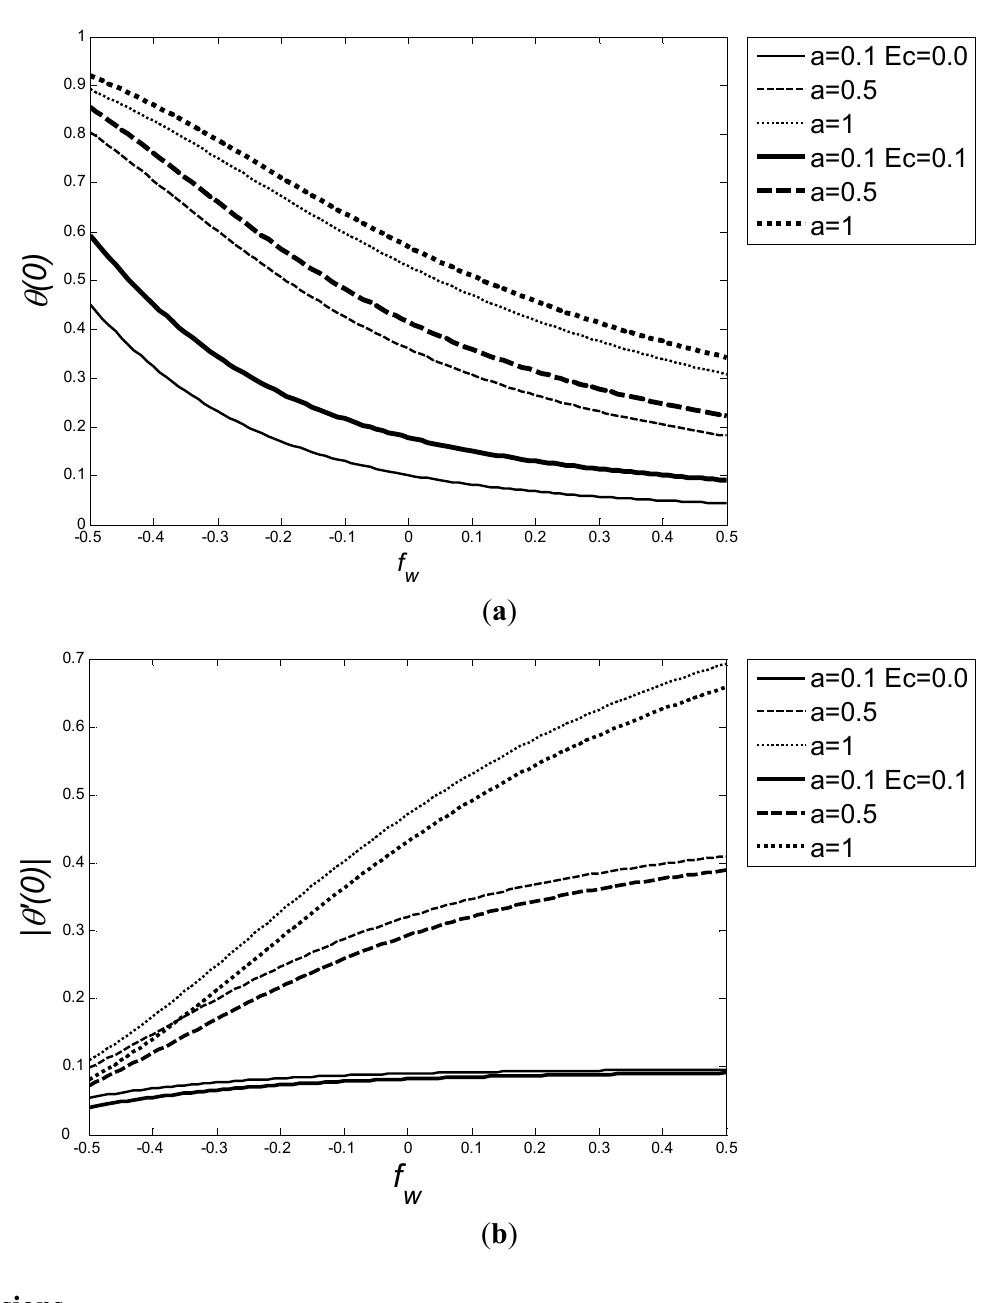
Figure 13. ( a ) Variation of the θ (0) and ( b ) | θ ' (0)| as a function of f and Ec when K = 0.5, Pr = 7 and M =